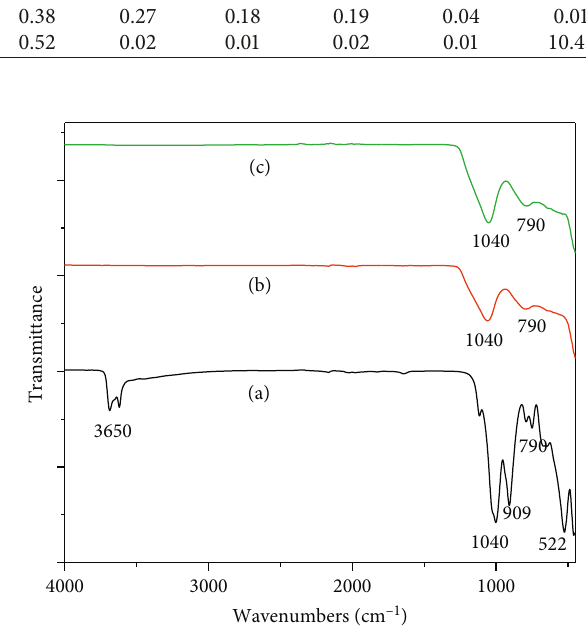
Figure 6: FTIR curves of (a) kaolinite, (b) metakaolinite at 700 ° C for 180min, and (c) residue after leaching at 0.10g · mL − 1 , 5 M, 80 ° C, and 180